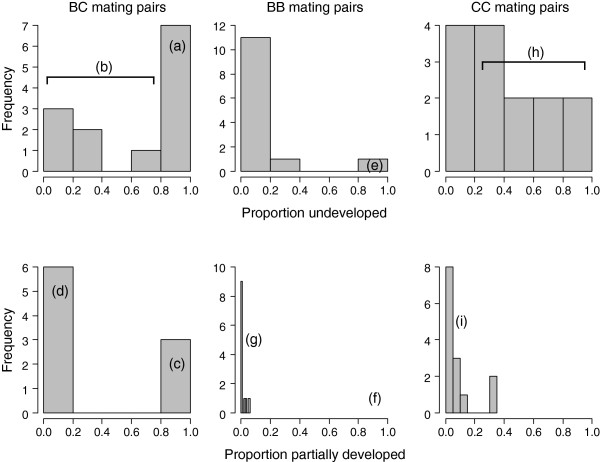
Frequency histograms of egg development across mating pair combinations. Histograms showing the frequency distributions of the proportion of eggs that did not develop (upper row), and the proportion of partially developed eggs (lower row), across each mating pair combination (by column left to right; BC, BB and CC). For BC mating pairs, more than half the clutches had a majority of undeveloped eggs (a). The remaining clutches varied in the proportion of undeveloped eggs and eggs beginning embryogenesis (b). Of these clutches showing signs of development, there was a bimodal distribution of either a majority of eggs partially developing (c), or eggs developing normally (d), rather than a normal distribution of development success. BB clutches rarely consisted of undeveloped eggs (e) or partially developed eggs (f). Instead, clutches had a majority of eggs that developed normally (g). The majority of CC clutches consisted of at least some undeveloped eggs (h). Of the eggs beginning embryogenesis, almost all developed normally (i).